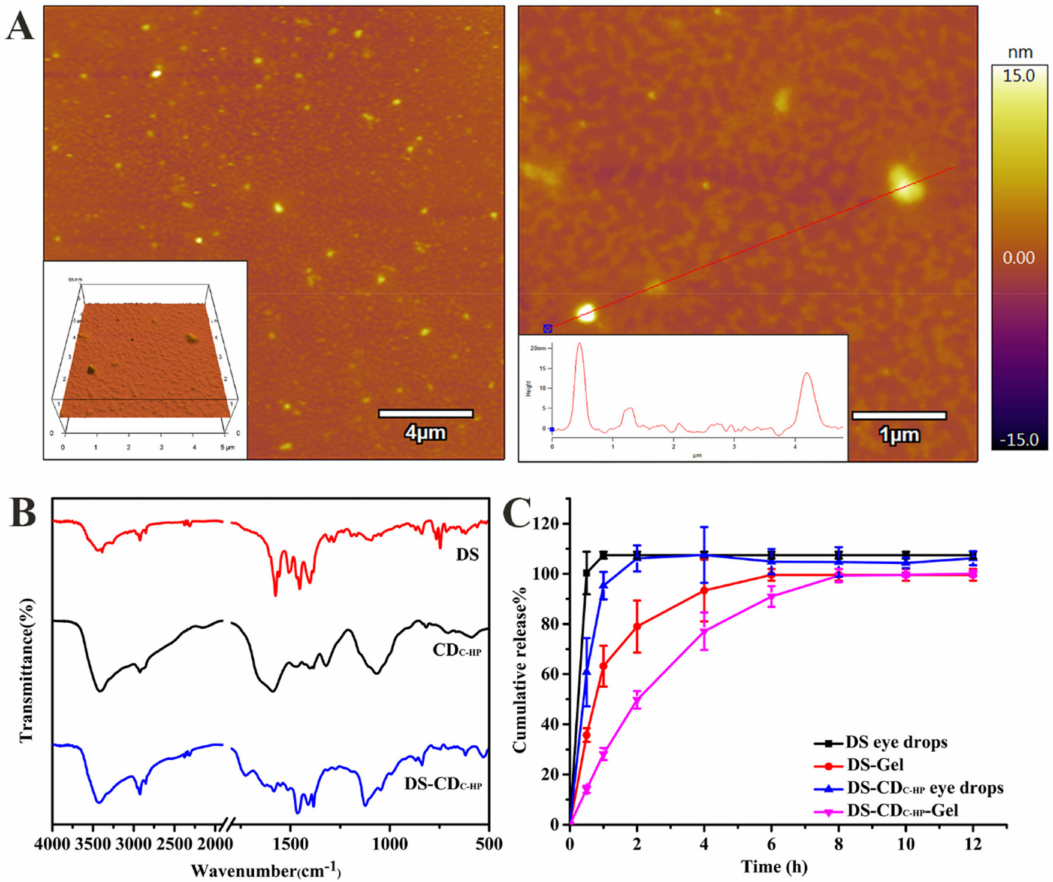
Figure 4. AFM images of DS-CD C-HP ( A ); FT-IR spectrum of DS, CD C-HP and DS-CD C-HP ( B ); in vitro release profiles of DS eye drops, DS-Gel, DS-CD C-HP eye drops and DS-CD C-HP -Gel ( C